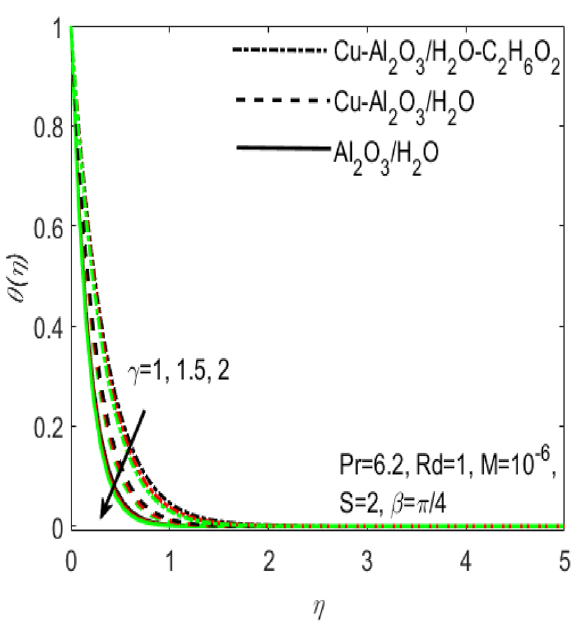
Figure 7. Influence of γ on θ(η) for different hybrid nanofluids and simple